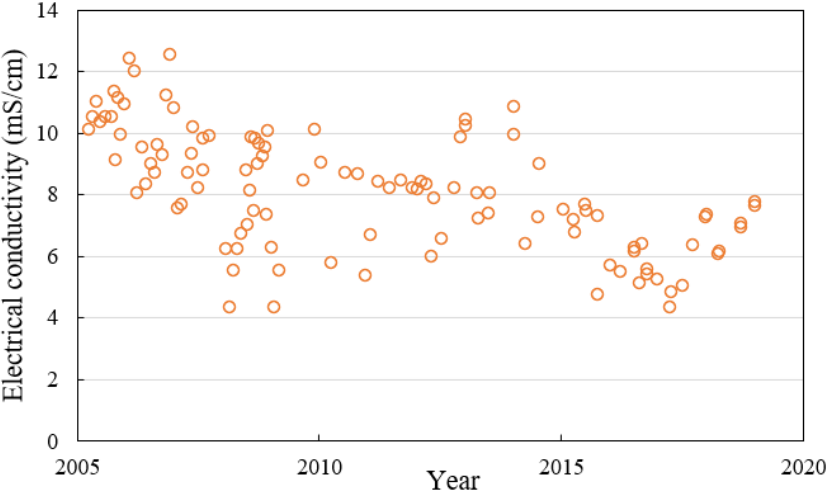
Figure 1. Electrical conductivity of the dam process water at a coal mine in Queensland, Australia.